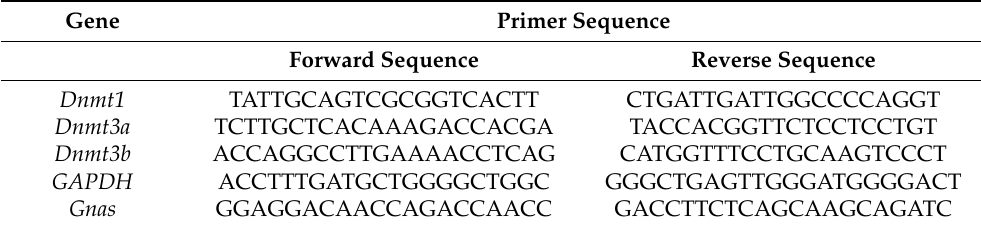
Table 1. Primer sequences for